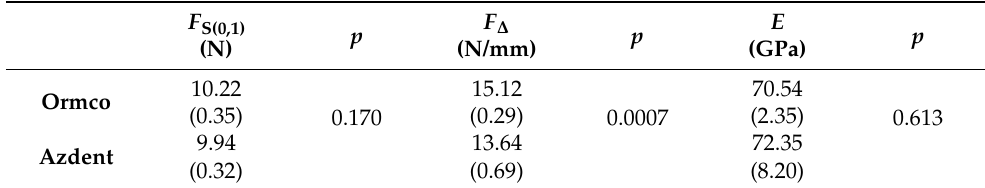
Table 6. Determined three-point bending test parameters of β -Ti products: offset bending force F S(0,1) , force-deflection rate F ∆ , flexural modulus of elasticity E (standard deviation), and statistical analysis result p values.